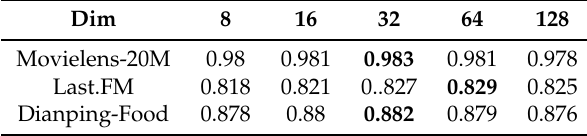
Table 5. Effects of different embedded dimensions on AUC.